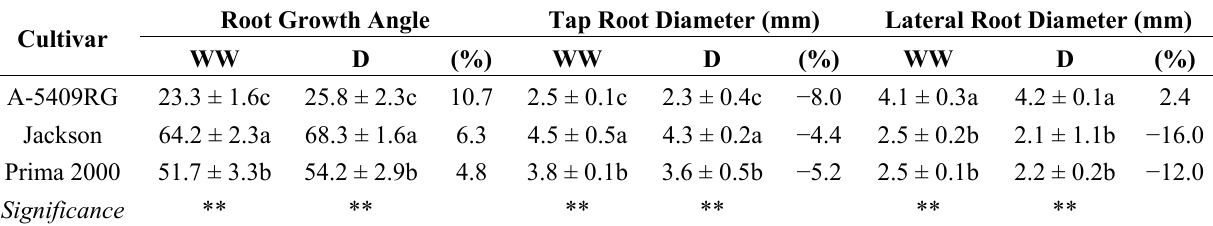
Table 1. A comparison of root traits in three field grown soybean cultivars: A5409RG, Jackson and Prima 2000, under well-watered conditions and after one of month drought